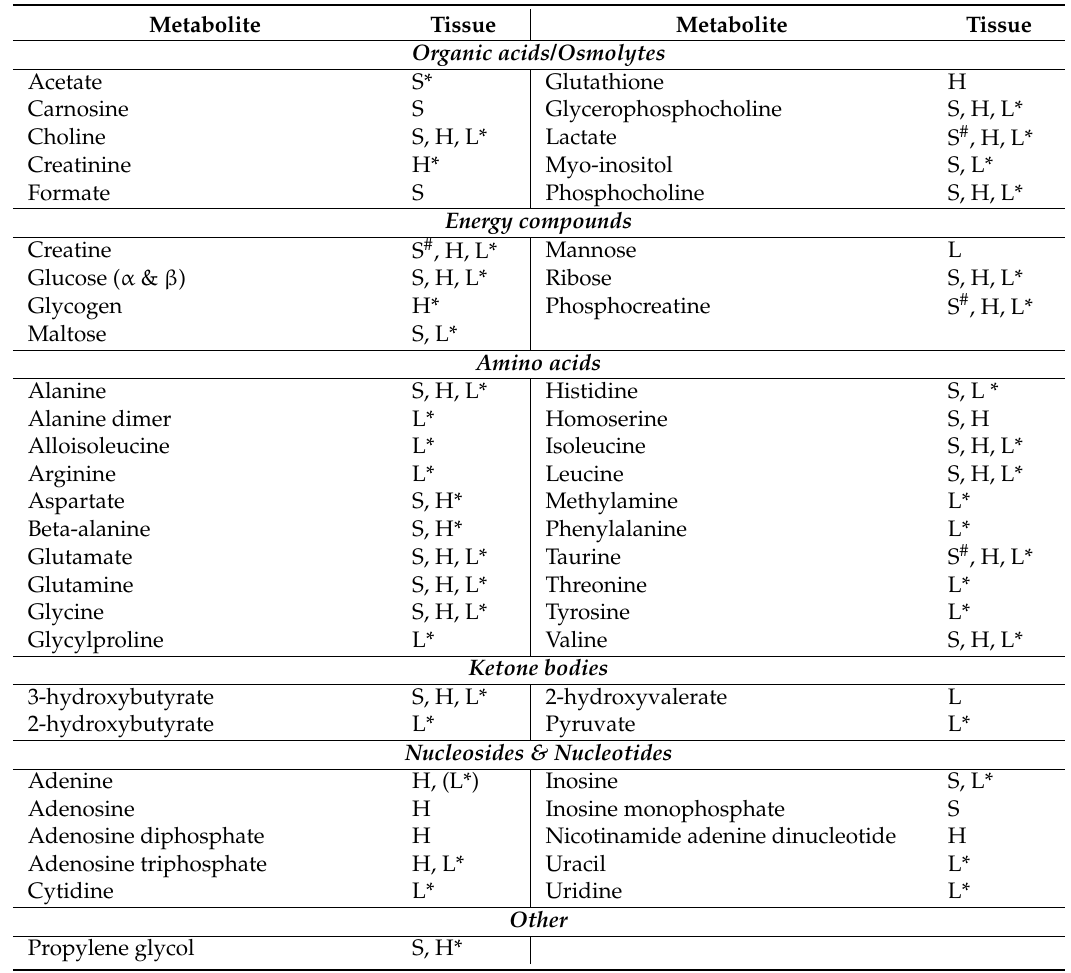
Table 1. Metabolites identified in the aqueous extracts of skeletal muscle, heart, and liver of hatchling loggerhead sea turtles ( Caretta caretta ) grouped by metabolite type. Key: Skeletal muscle (S), Heart (H), Liver (L); (*) Confirmed using 2D NMR +/ − 1D 31 P NMR experiments, laboratory standards +/ − predicted spectra (ACD SACD11/C+H Predictor and DB). (#) Metabolites that met the